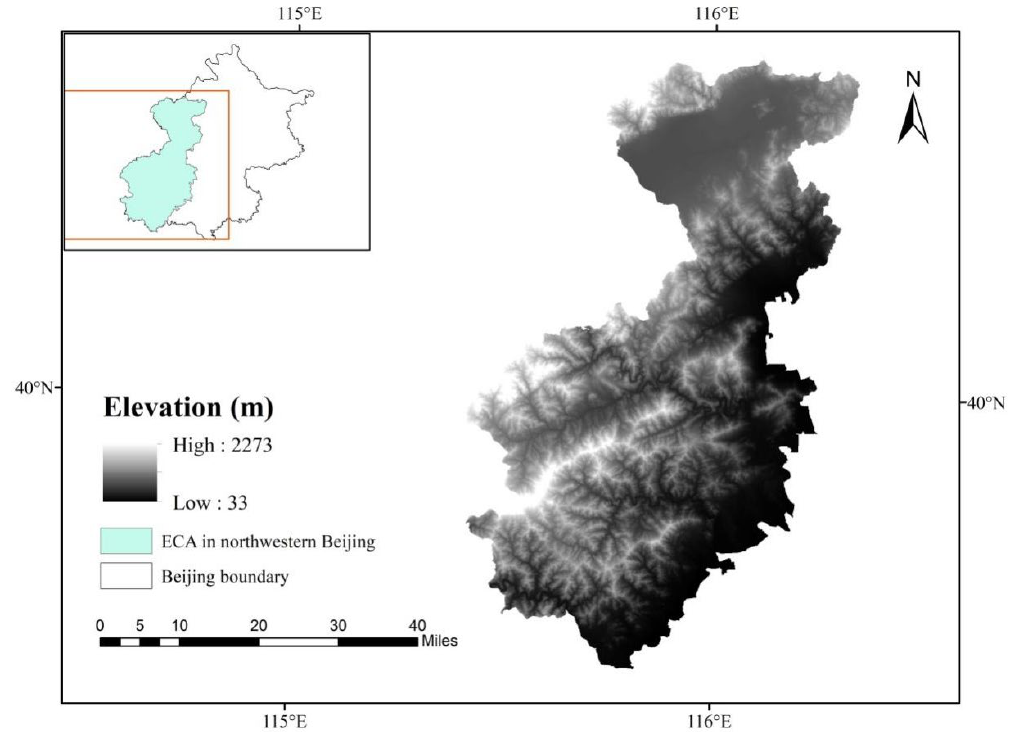
Figure 1. Location of the ECA study area within the Beijing boundary.